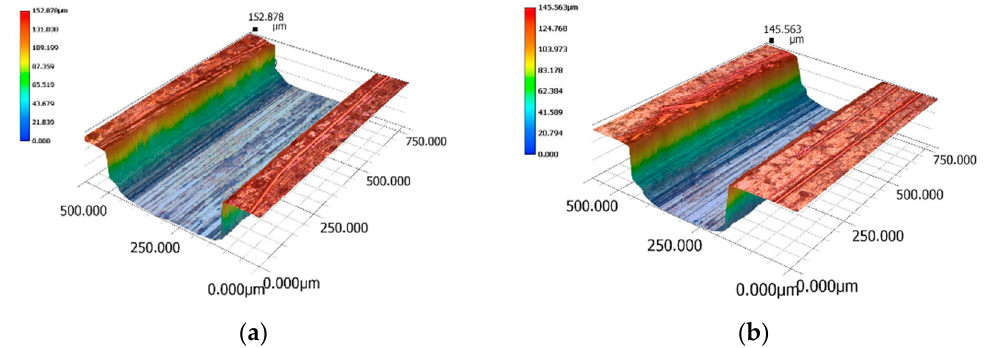
Figure 7. Three dimensional digital microscope images of machined cavities for 0.3 mm ( a ) and 0.2 mm ( b ) wide